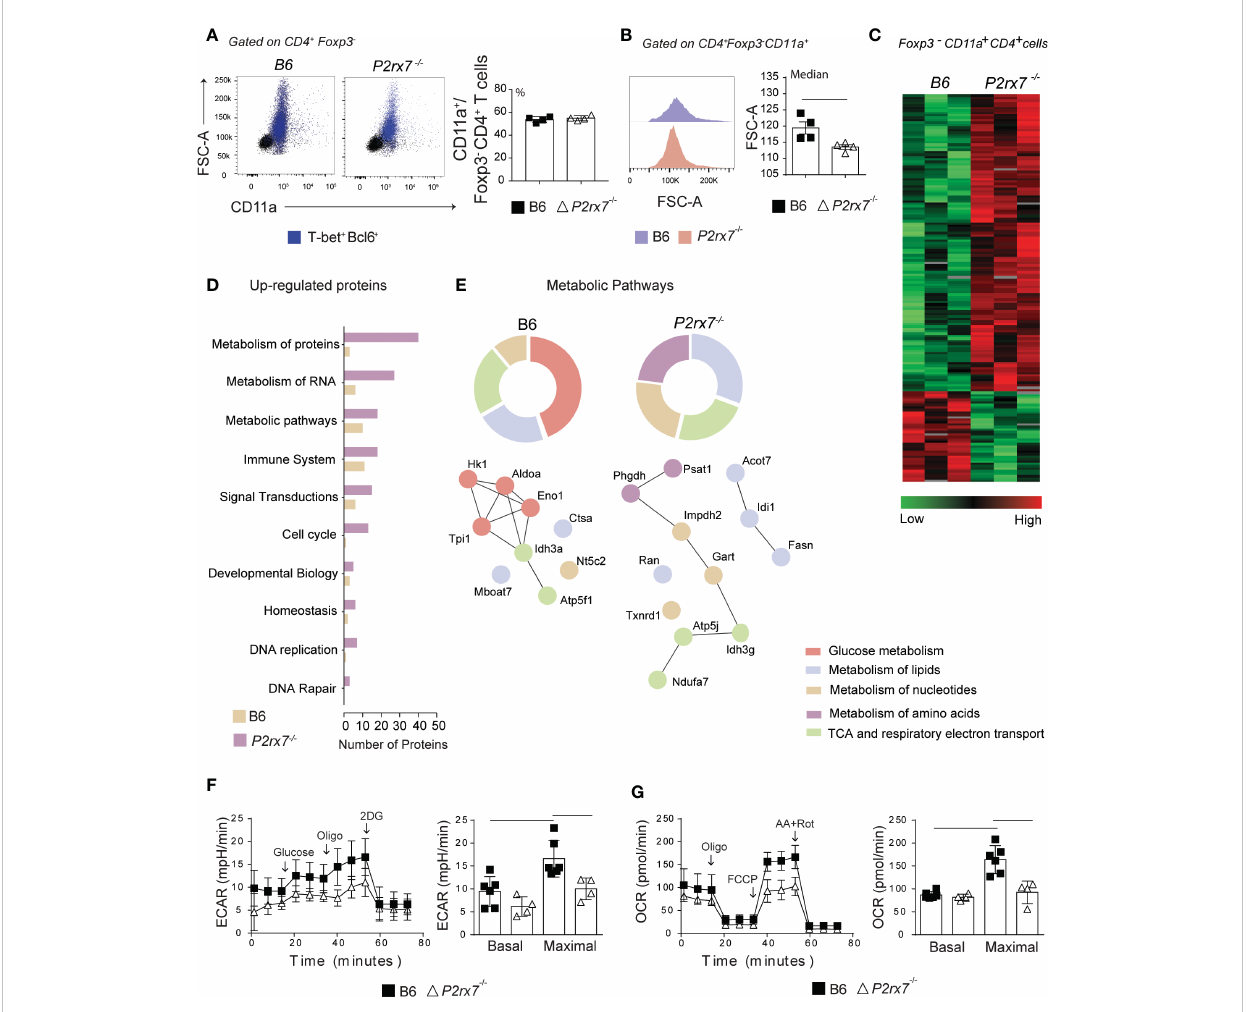
FIGURE 2 Metabolic analysis of splenic CD4 + T cells from B6 and P2rx7 -/- mice at early Plasmodium infection. Foxp3.GFP and Foxp3.GFP + P2rx7 -/- mice were infected i.p. with 1 x 10 6 iRBCs and analyzed 6 days later. (A) Dot plots show forward side scatter area (FSC-A) and CD11a expression in Foxp3 - CD4 + T cells. Blue dots identify T-bet + Bcl6 + cells. Column bar graph shows CD11a + cell frequencies in the Foxp3 - CD4 + T cell population. (B) Histograms show FSC-A of CD11a + Foxp3 - CD4 + T cells. Column bar graphs show FSC-A medians. (C) The heatmap of label-free quantitative data shows upregulated proteins in red and downregulated proteins in green. (D) Functional groups of biological pathways de fi ned by Reactome Database show upregulated proteins. (E) Enrichment of metabolic pathways de fi ned by Reactome Database is shown. The upregulated proteins are provided in the interaction network and their fi rst nodes. (F and G) Real time changes in extracellular consumption acidi fi cation rate (ECAR) and oxygen consumption rate (OCR) were measured using a Seahorse XFe96 bioanalyzer. (F) The fi rst arrow indicates the injection of glucose to increase the glycolytic pathway, followed by oligomycin to enhance the glucose consumption (second arrow) and 2-deox-D-glucose (2DG) to inhibit glycolysis (third arrow). (G) The fi rst arrow indicates the injection of oligomycin that promotes a metabolic stress, followed by a mitochondrial decoupler carbonyl cyanide p-tri fl uoro-methoxyphenyl hydrazone (FCCP) to determine the maximal respiratory capacity (second arrow) and antimycin A/ rotenone to block the electron transport chain (third arrow). Data are shown as the mean ± SD (n = 4) of one representative experiment out of three. Signi fi cant differences were observed for the (-) indicated groups with p < 0.05, using the Mann Whitney